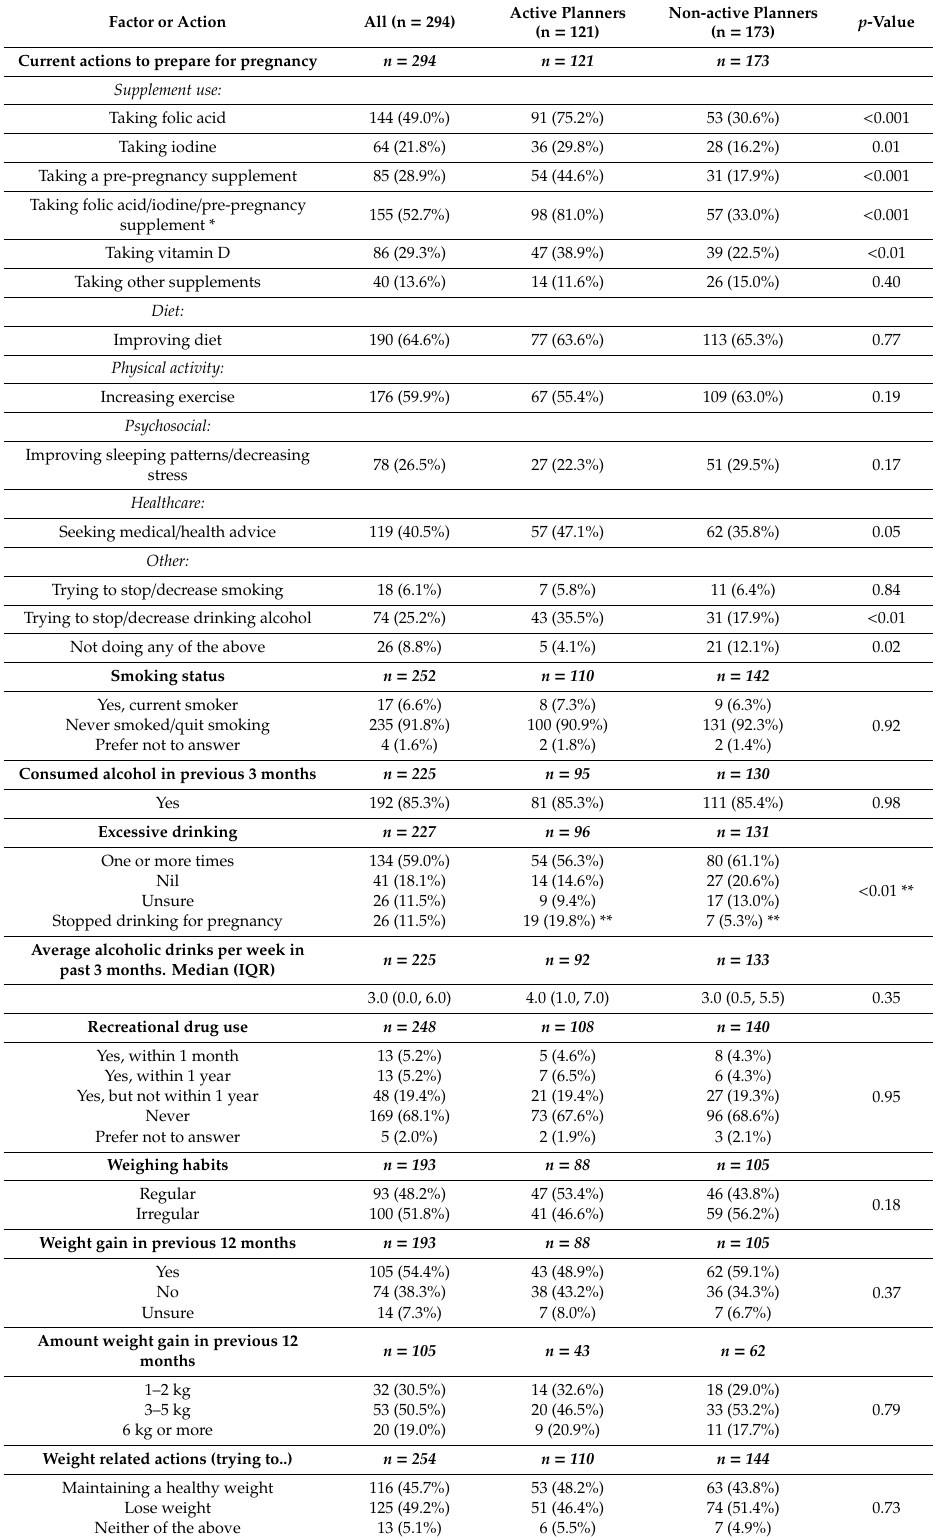
Table 4. Actions to prepare for pregnancy, unhealthy lifestyle behaviours and modifiable risk factors, stratified by pregnancy